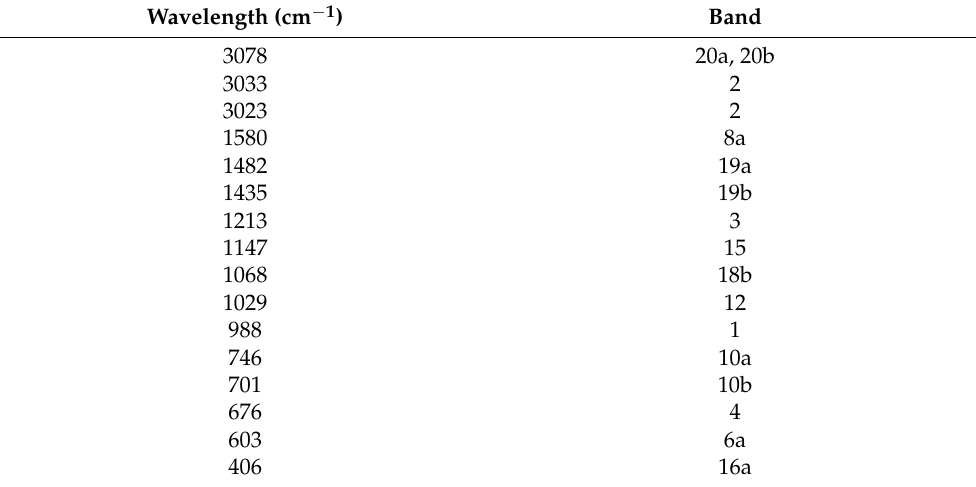
Figure 6. Infrared spectra of pyridine (Py) concentrated alone and pyridine on the support doped for 10 min in a concentration of 10 mM AgNO 3 . Table 1. Infrared spectrum bands obtained from Py concentrated alone and Py on the support doped for 10 min in a concentration of 10 mM AgNO 3